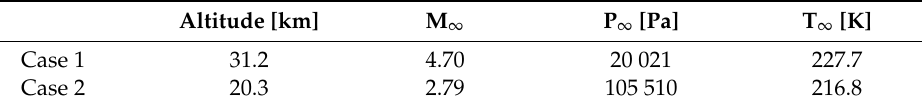
Figure 13. Mesh of validation case.